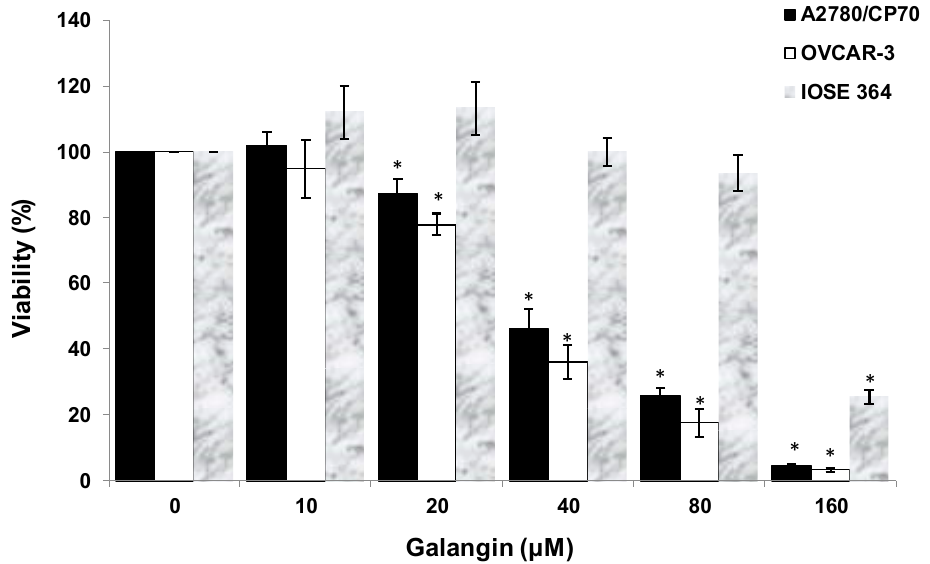
Figure 2. E ff ect of galangin on the viability of ovarian cells. Cell viability was determined by 3-(4,5-dimethylthiazol-2-yl)-2,5-diphe-nyltetrazolium bromide (MTT)-based method and expressed as percentages of the control. All cells (1 × 10 4 / well) were seeded into 96-well plates and incubated overnight before being treated with galangin at di ff erent concentrations. * p < 0.05 as compared to the control.